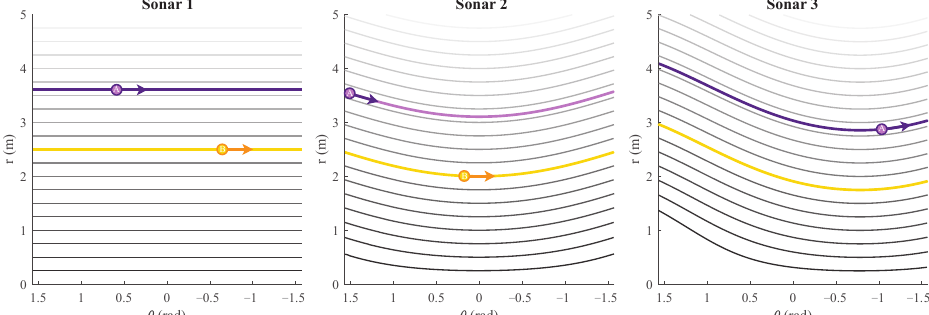
Figure 5. The ( r ( t ) , θ ( t )) flow-lines for a positive rotation movement ω are marked for sonar sensors 1, 2, and 3 and reflections A and B of Figure 4a. The arrow indicates the direction the reflection would move with such a motion. The flow-lines for other distances falling in range ( r ∈ [ 0; r max ] ) are also shown, with r max being the maximum detected range of the eRTIS